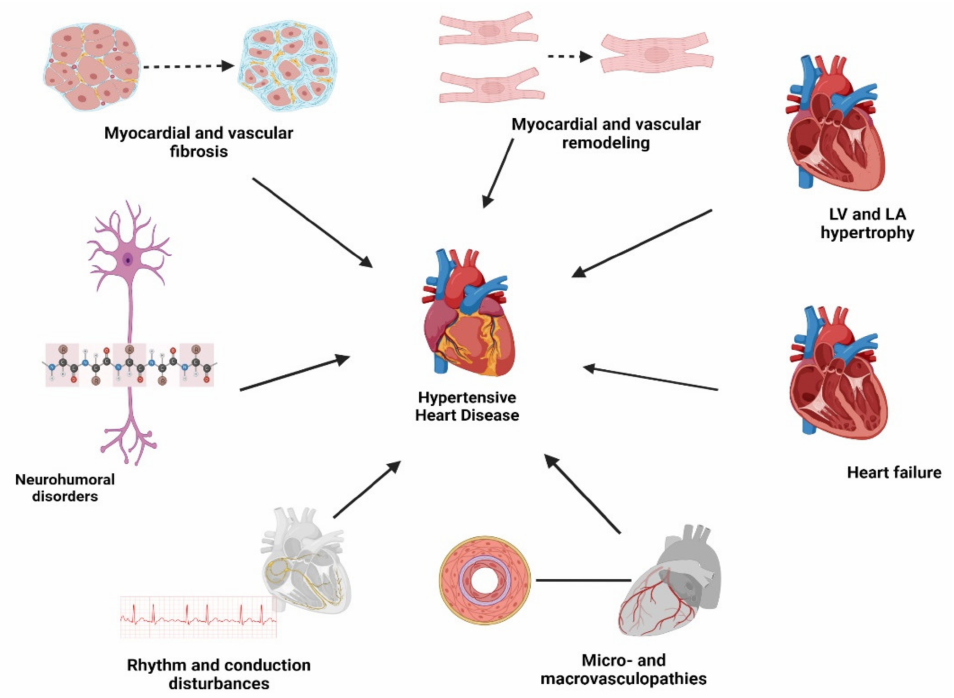
Figure 1. Pathomorphological, pathophysiological, and clinical patterns of hypertensive heart disease. LV – left ventricle, LA – left atrium. Figure created with